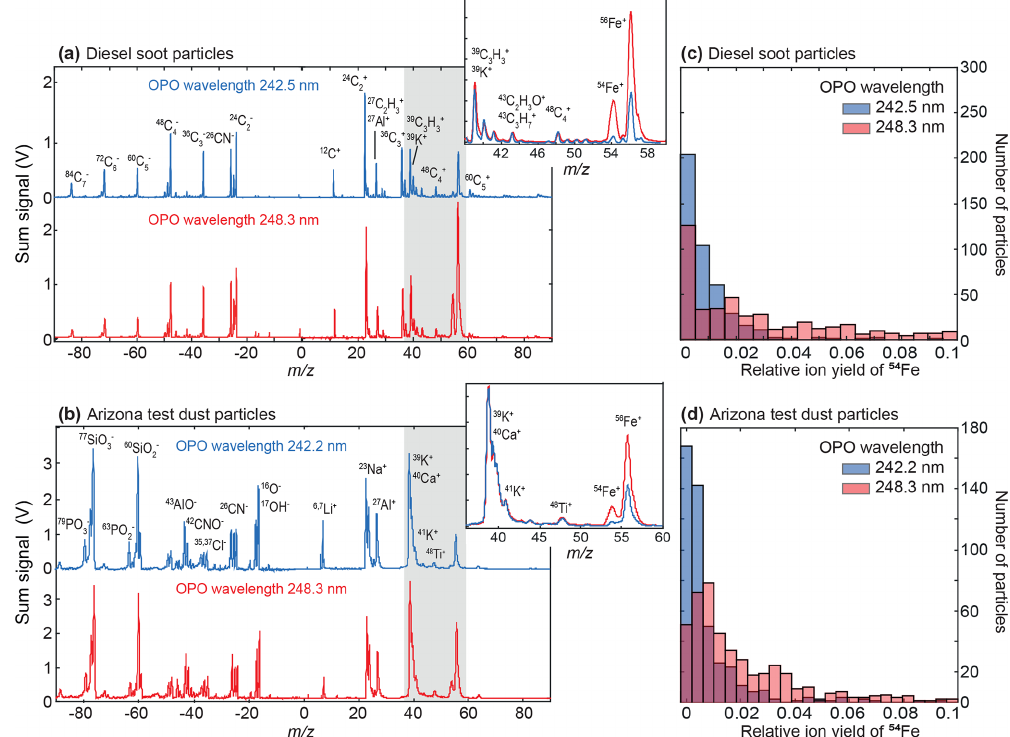
Figure 1. (a) Accumulated mass spectra (every n = 400) of re-dispersed diesel soot particles ionized using the tuneable OPO laser. In the case of resonant ionization of Fe at 248.3nm (red), the Fe signal is substantially enhanced compared to the nonresonant ionization at 242.5nm (blue); see the inset for an enlarged view of the grey area. Most other signals are similar. (b) A comparable Fe enhancement can be observed for mineral dust particles. The histogram panels (c) and (d) of the single-particle relative ion signal ( 54 Fe + signal normalized to the particle’s total ion yield) illustrate that the ionization enhancement accounts for the majority of analyzed particles. Corresponding normalized mass spectra are shown in Fig. S2, and the particle size distributions are depicted in Fig.